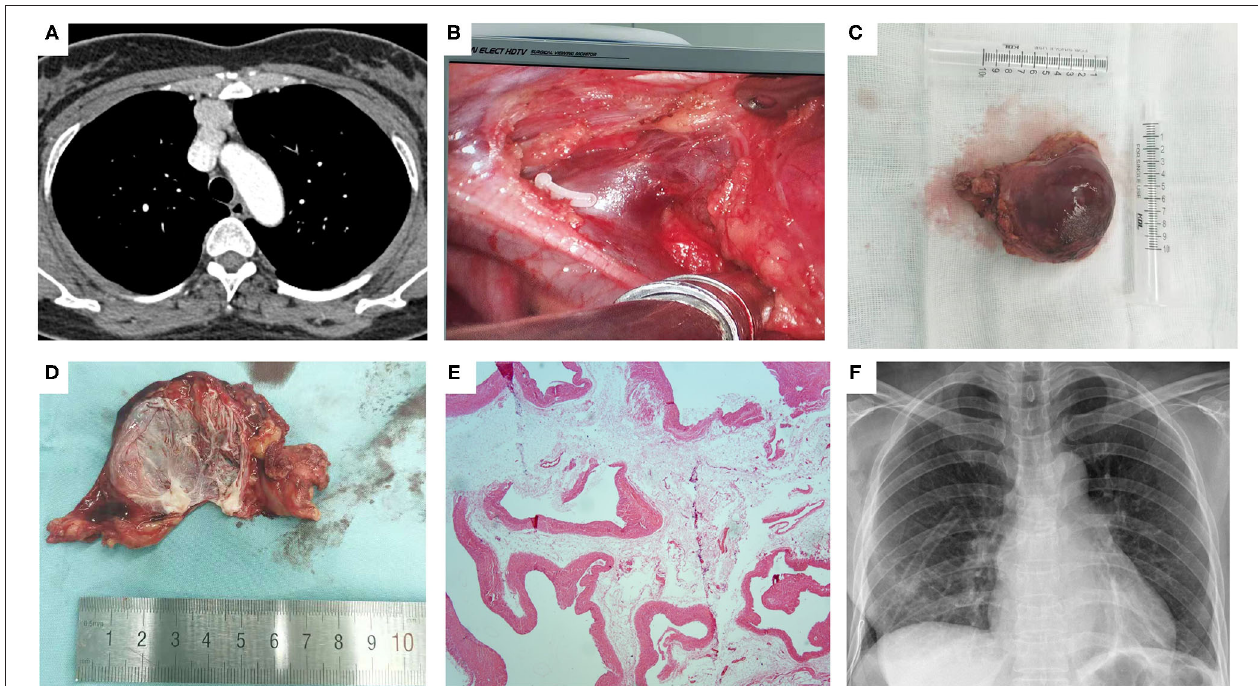
FIGURE 1 | The left innominate vein aneurysm. (A) Contrast-enhanced CT of the chest showed a 4.8 × 4.6cm anterior mediastinal mass with significant homogenous enhancement after injection of the contrast; (B) Intraoperative view of the root of the aneurysm after dividing the left internal thoracic vein with a vascular clamp; (C) Gross appearance of the aneurysm; (D) Gross appearance of the cut-up aneurysm after the blood being flowed away; (E) Postoperative pathology confirmed the diagnosis of the left innominate vein aneurysm; (F) Chest radiography on postoperative day 1 showed complete reexpansion of the lung, with no obvious pneumothorax or